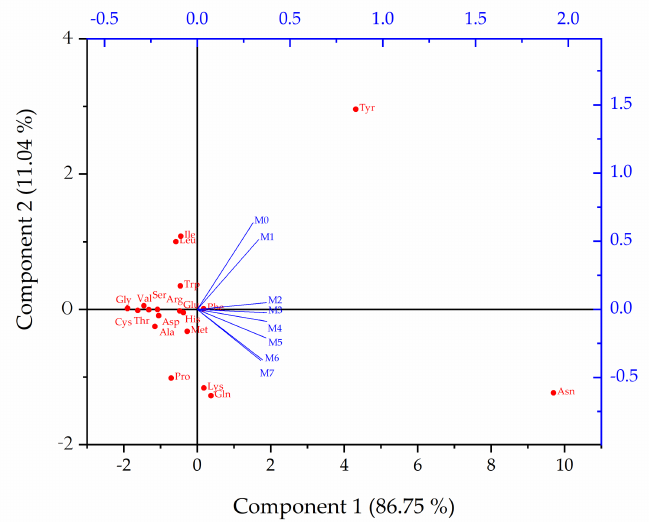
Figure 4. PCA score plot of amino acids. M0 − M7 are mulberry fruits during ripening stages. Ala: alanine; Arg: arginine; Asn: asparagine; Asp: aspartic acid; Cys: cysteine; Gln: glutamine; Glu: glutamic acid; Gly: glycine; His: histidine; Ile: isoleucine; Leu: leucine; Lys: lysine; Met: methionine; Phe: phenylalanine; Pro: proline; Ser: serine; Thr: threonine; Trp: tryptophan; Tyr: tyrosine; Val: